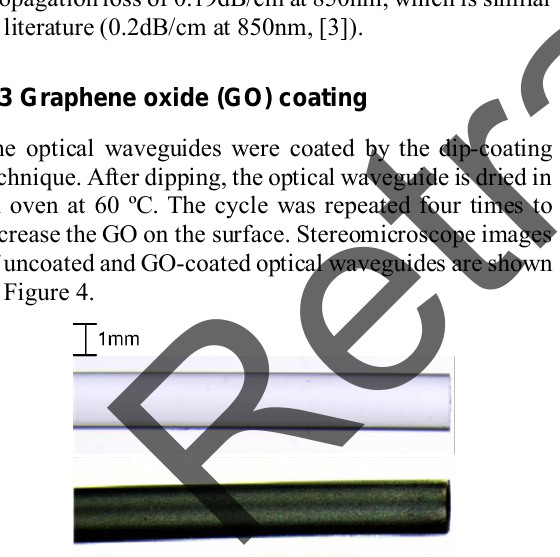
Fig 4. Stereomicroscope images of uncoated (top) and GO- coated (bottom) PMMA optical waveguides.